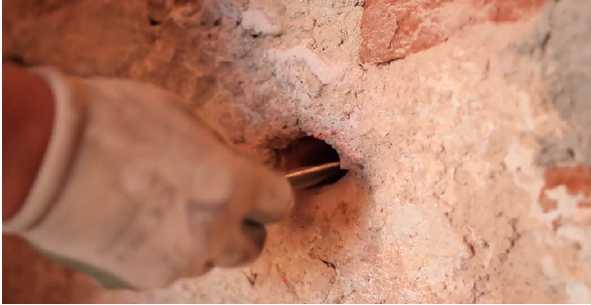
Figure 12. Housing of a threaded bar in a drilled hole [54].